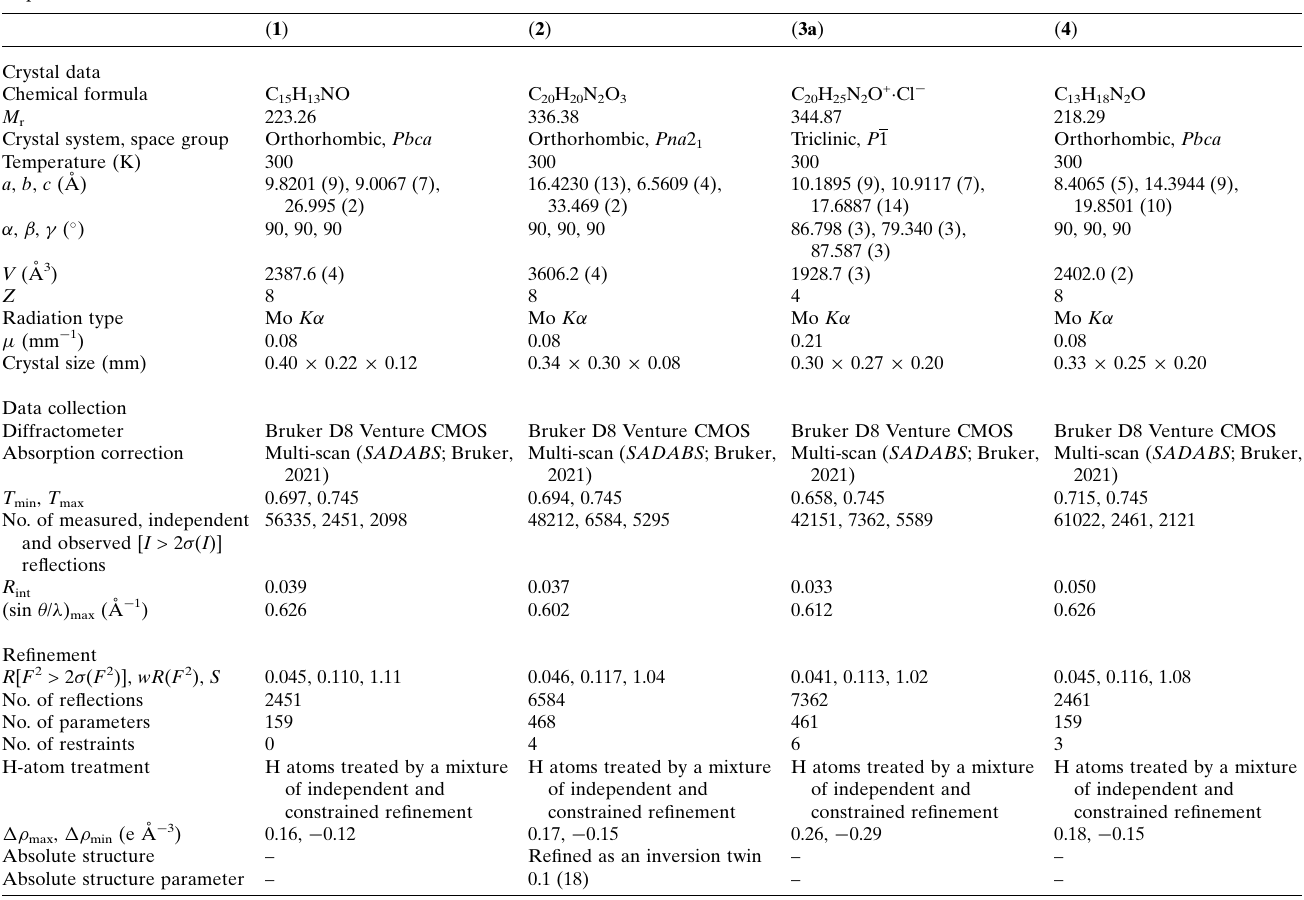
Table 4 Experimental details.